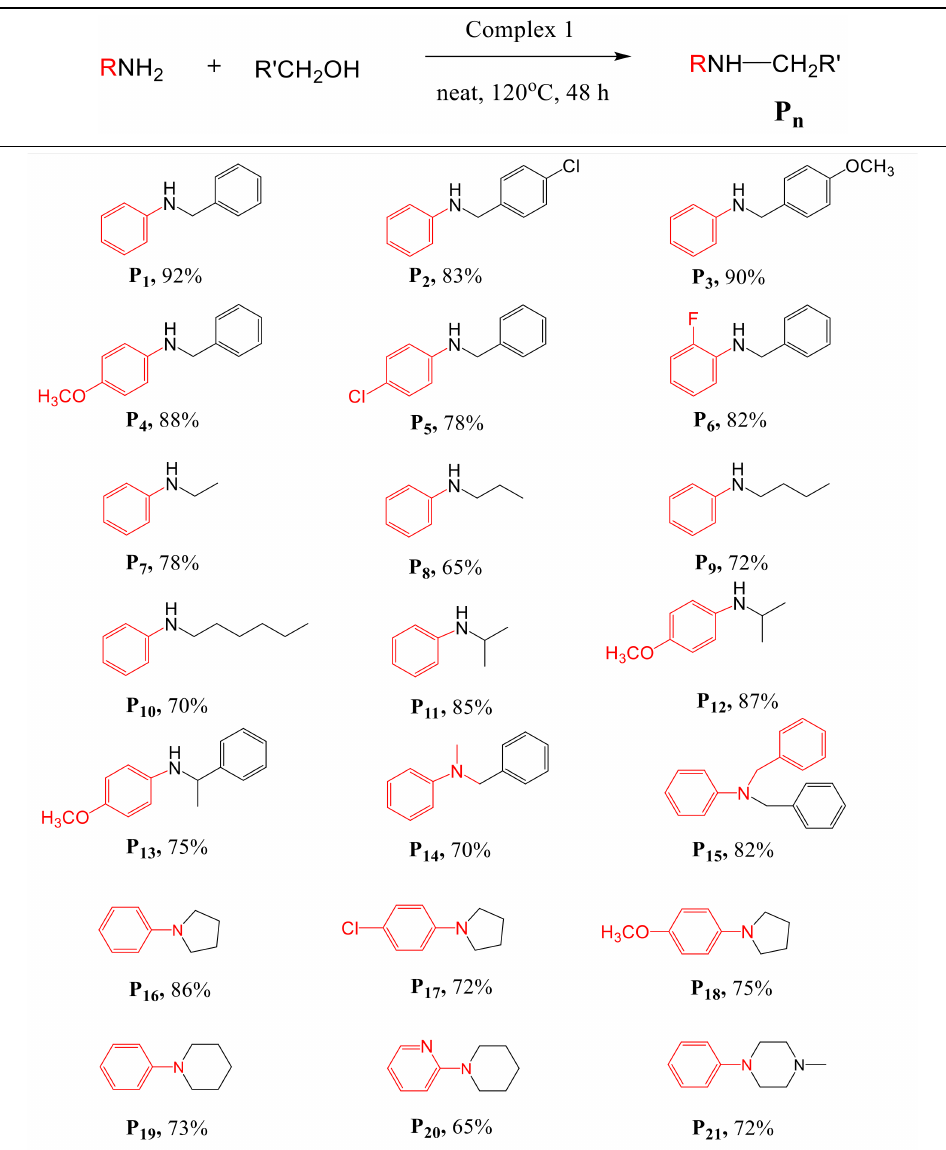
Table 3. Complex 1 catalyzed N-alkylation of